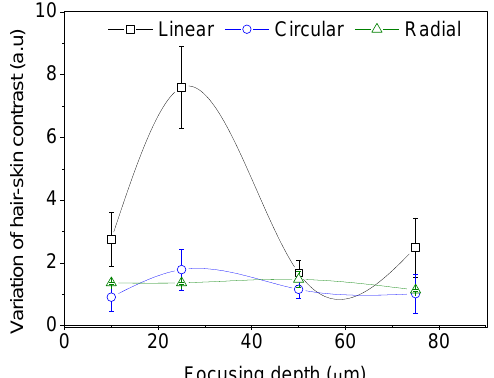
Figure 5. Variation of hair-air contrast measured on non-medullated black hair ( in-vivo ) as a function of focusing depth inside hair for different orientations of incident